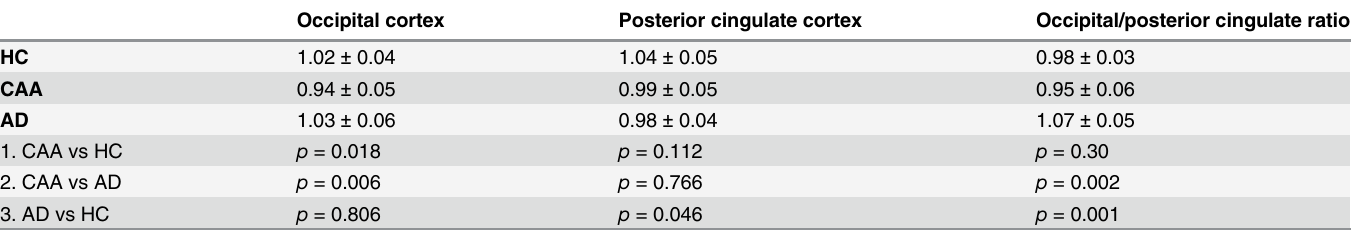
Table 3. SUVR data (mean ± 1SD) for the three selected ROIs among the three groups of subjects, namely aged-matched healthy controls (HC; n = 9), probable cerebral amyloid angiopathy (CAA; n = 11) and probable Alzheimer ’ s disease (AD; n = 7). For the ROI data, statistical comparison among the three groups was carried out using ANOVAs followed by post-hoc Tukey tests whenever the ANOVA was significant. For the occipital/PCC ratio, the comparisons were made using the non-parametric Mann-Whitney test. See Results for details.